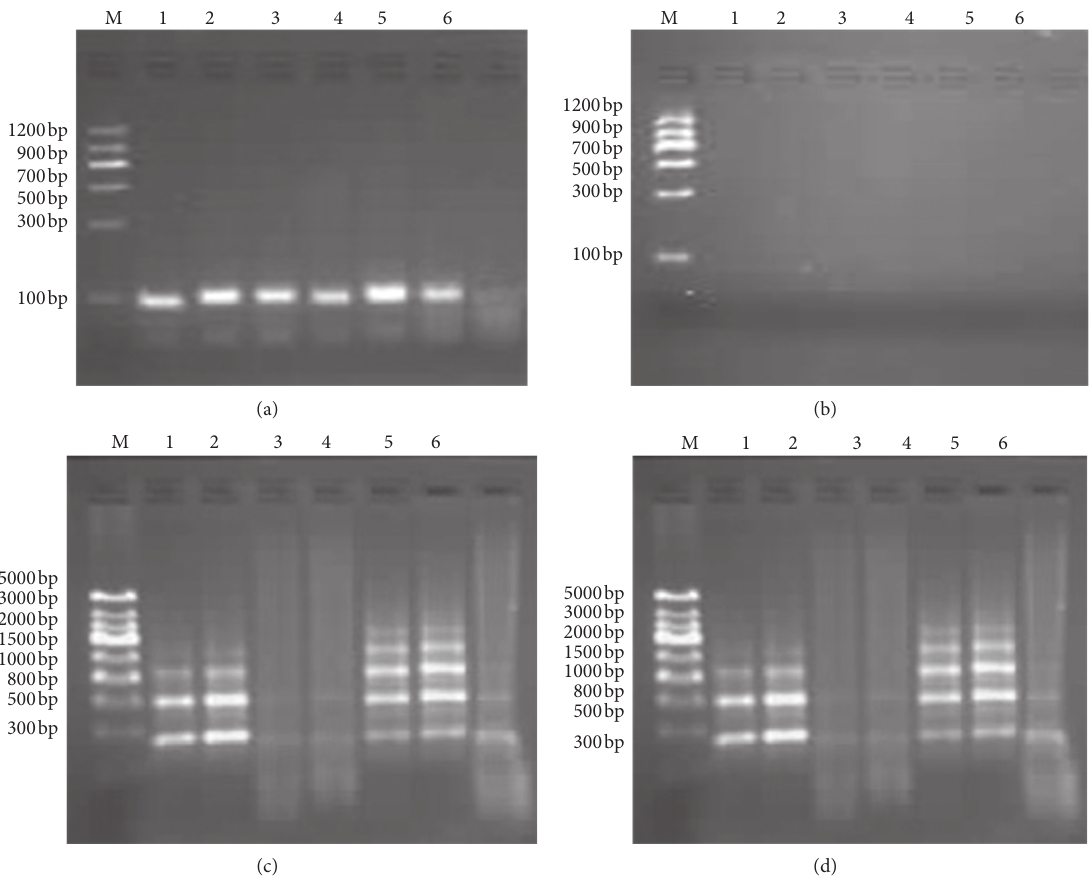
Figure 2: Electropherogram of target gene fragment in HCR. The lanes on both sides of the gel are DNA markers; lanes 1–6 represent six soybean cultivars in sequence: Wuhei, Jinda 73, Jinyi 30, Jinke 4, WS 285, and Jinda 47 in HCR system. (a) Double-strand target gene (TF/TR) amplified by PCR. (b) Agarose gel analysis of the PCR product digested by lambda exonuclease. (c) Agarose gel analysis of HCR products in the presence of probes GAa1 and GAa2. (d) Agarose gel analysis of HCR products in the presence of probes GAb1 and GAb2.